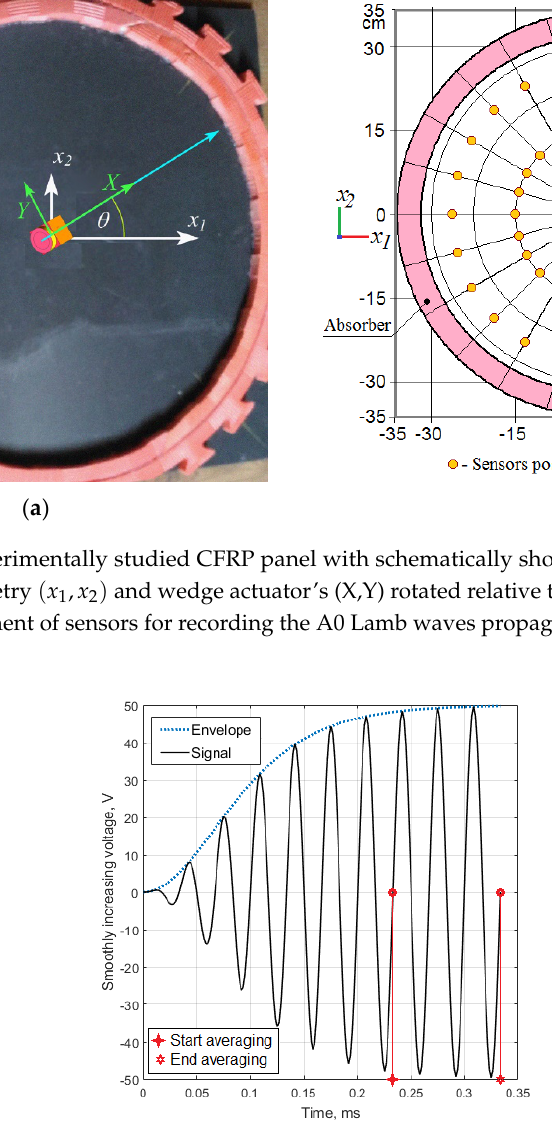
Figure 8. The driving voltage for the PZT actuator and the time interval for the sensor’s signal